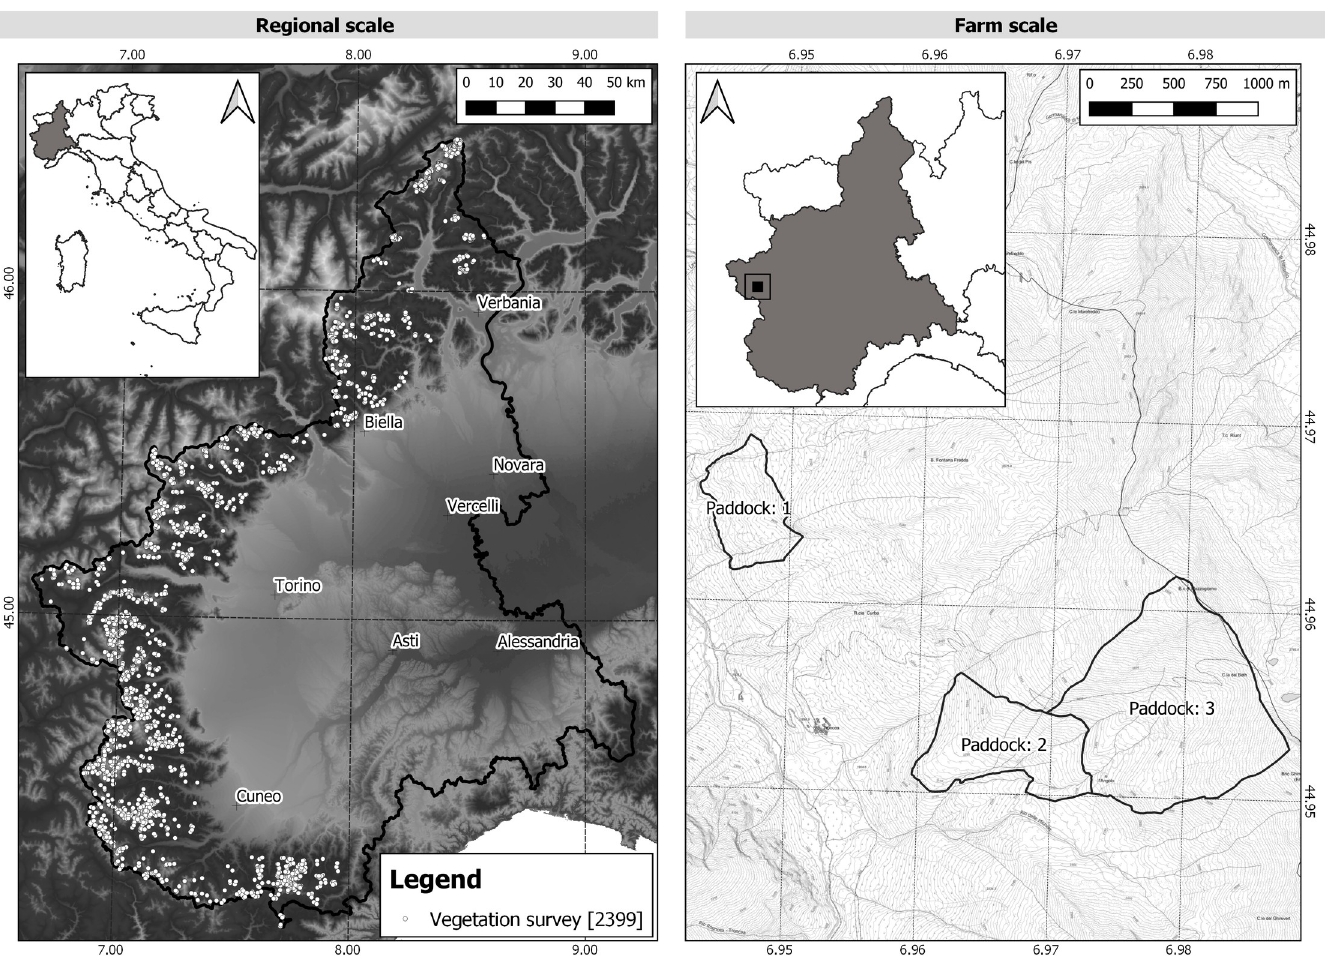
Fig 1. Distribution of 2399 vegetation surveys belonging to shrub-encroached, oligotrophic, mesotrophic, eutrophic, and nitrophilous Vegetation Ecological Groups spread over the summer pastures of Piedmont Alps and used for the regional-scale study (Image on the left). Location of the three large pastures in Val Troncea Natural Park, Piedmont region, used for the farm-scale study (Image on the right). Coordinate reference system: WGS84. Background map sources: Copernicus Land Monitoring Service—EU-DEM of the European Environment Agency (Image on the left) and maps drawn by Disafa based on Cartographic Reference Layout BDTRE 2018 Black/White 1:10.000 of the Piedmont Region. (Image on the right).